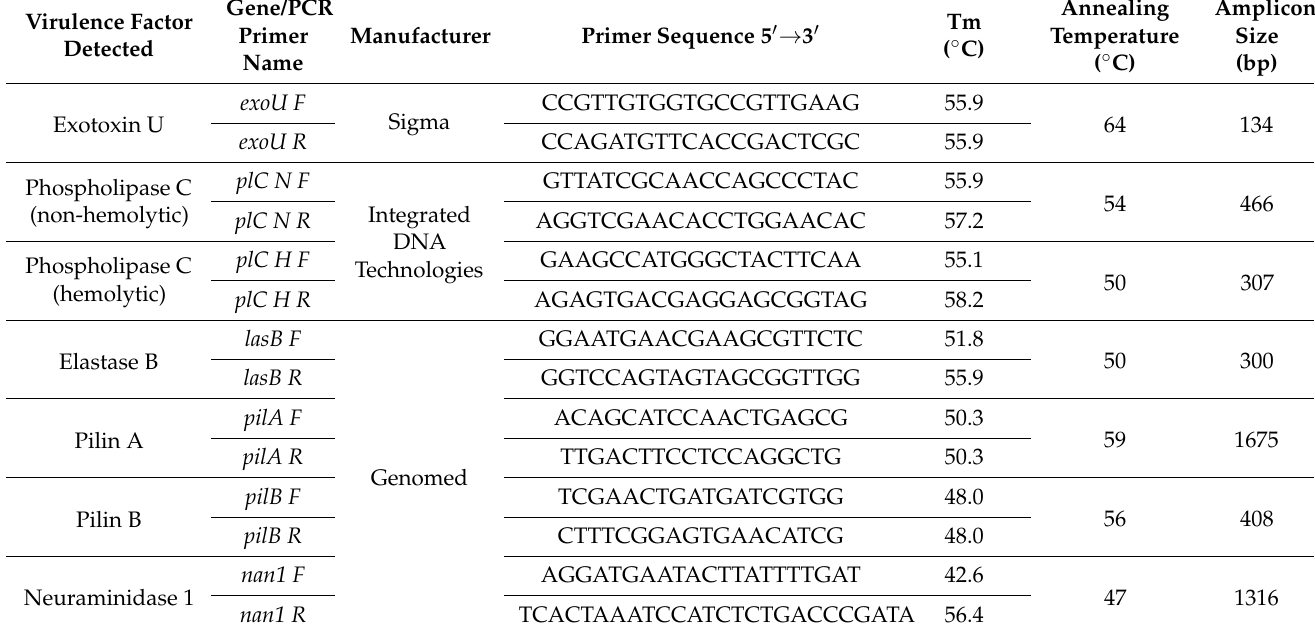
Table 3. Specification of the PCR primers and parameters applied in the present